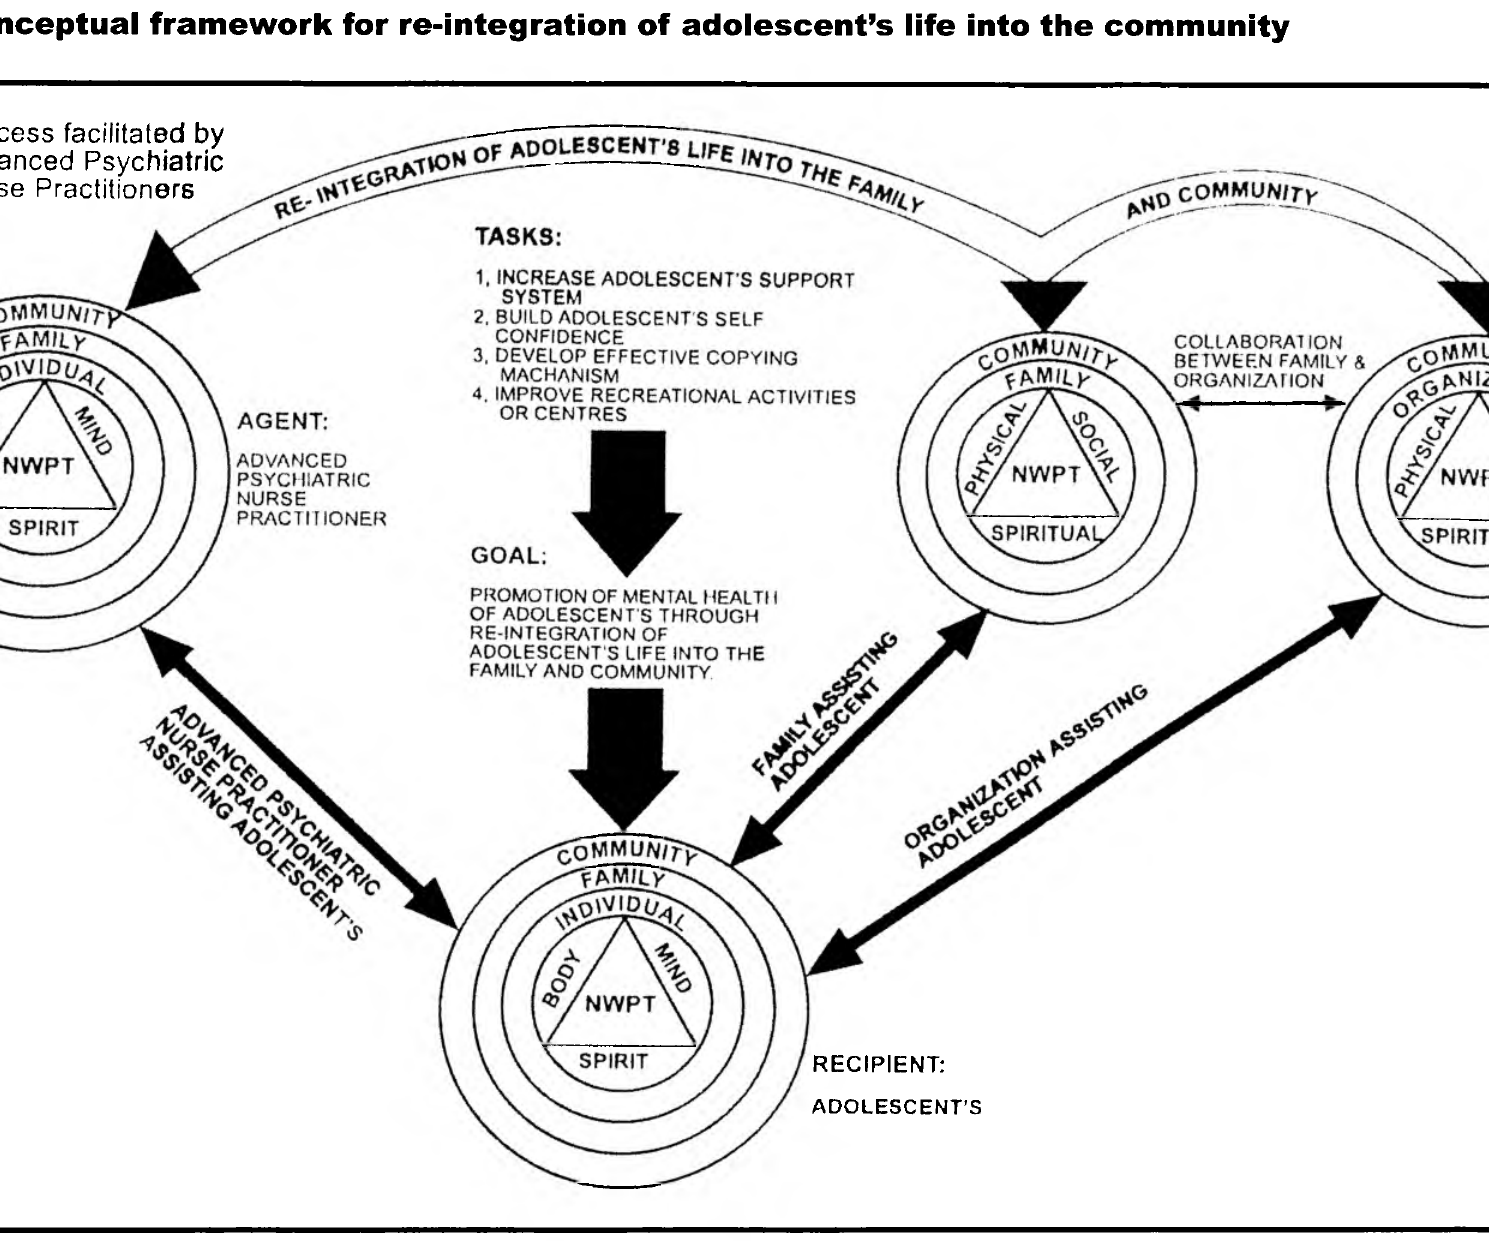
Figure 1 : Conceptual fram ew o rk for re-integration of adolescent’s life into the com m unity